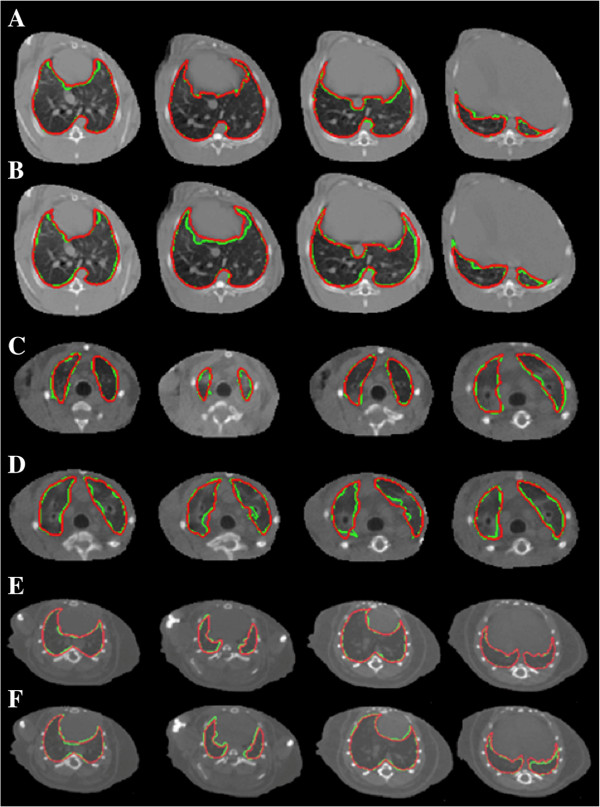
Intra- and inter-observer variability for different anatomical (CT) slice levels for rabbit, ferret, and mouse animals. (A,C,E) Multiple CT axial image slices from a rabbit, ferret, and mouse that have been segmented manually using a live-wire algorithm, by the same operator, in two different time points (red, time number 1, green, time number 2). (B,D,F) Rabbit and ferret segmentations from two different observers highlighted in red and green, respectively, across multiple lung locations. Intra-observer (A,C,E) and inter-observer (B,D,F) evaluations of the segmentation process show good agreement across four different lung locations. Quantitative evaluations of these processes are reported in Table
3.